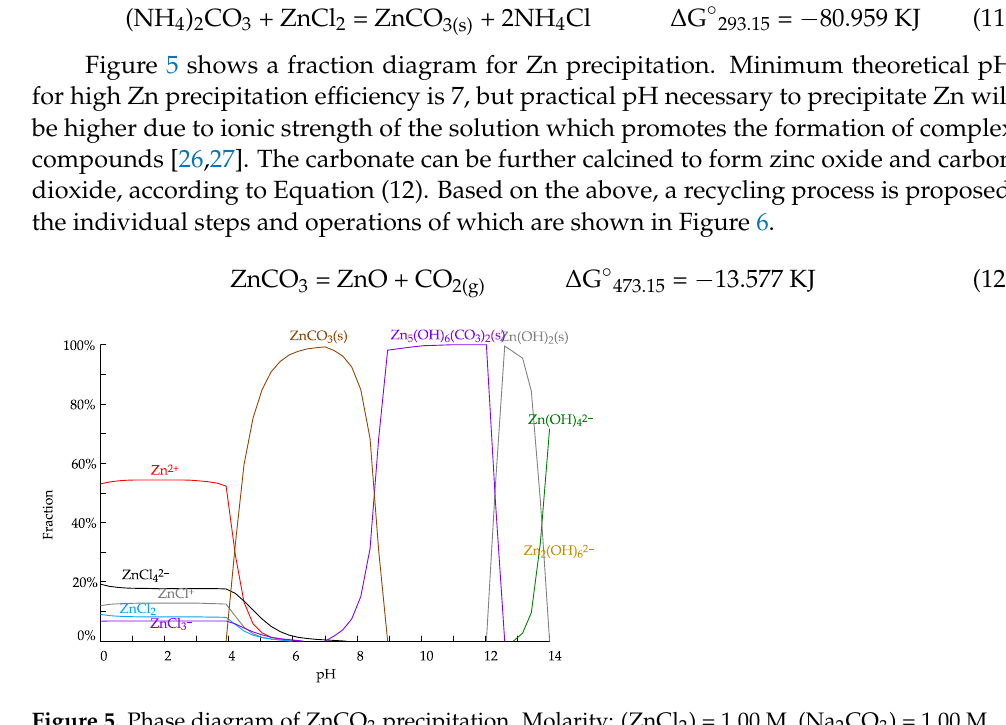
Figure 5. Phase diagram of ZnCO 3 precipitation. Molarity: (ZnCl 2 ) = 1.00 M, (Na 2 CO 3 ) = 1.00 M.